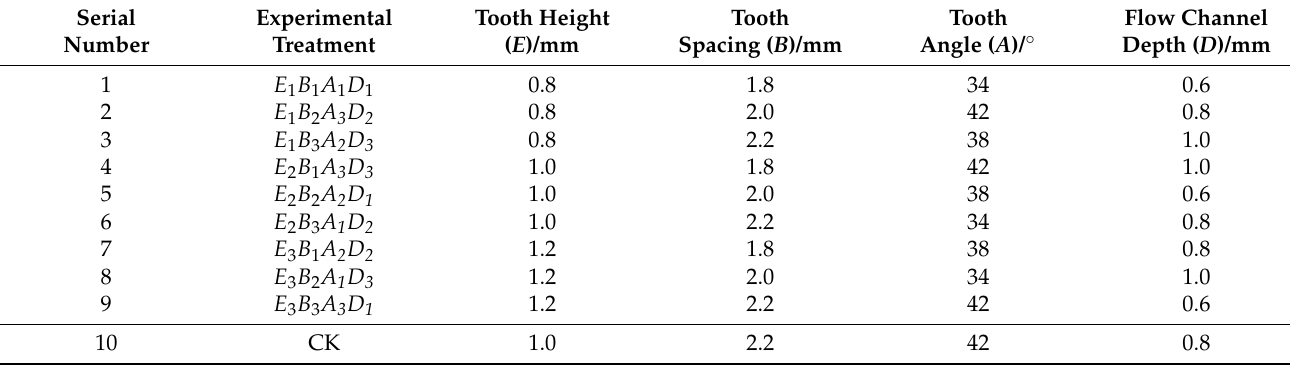
Table 1. Experiment design.